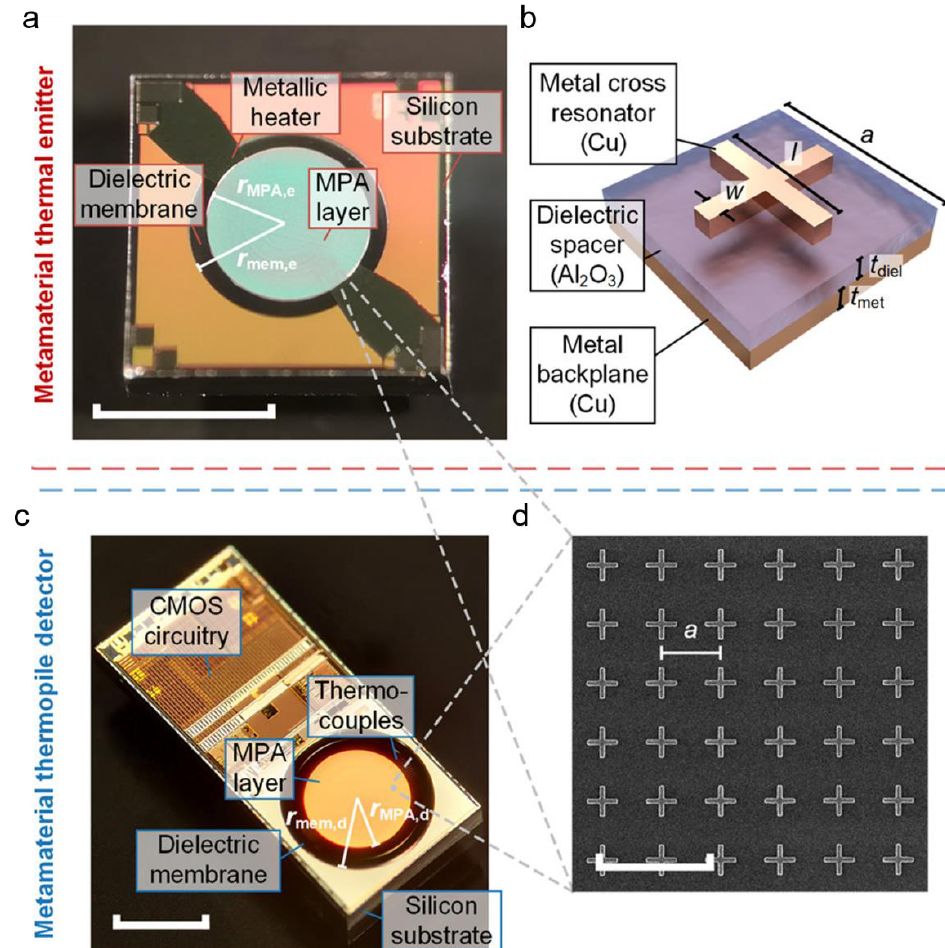
Figure 6. Metamaterial components. ( a – d ) Metamaterial thermal emitter. ( a ) The MPA layer (r MPA,e = 450 μm) is fabricated on a suspended dielectric membrane (r mem,e = 550 μm) with an integrated metallic heater (scale bar: 1 mm). ( b ) MPA unit cell. ( c ) The MPA layer (r MPA,d = 540 μm) is post-processed on top of a suspended dielectric membrane (r mem,d = 700 μm) with embedded thermocouples (scale bar: 1 mm). CMOS circuitry for signal amplification and processing is integrated on the same substrate. ( d ) Scanning electron micrograph of 6 × 6 MPA unit cells (scale bar: 4 μm). [93]